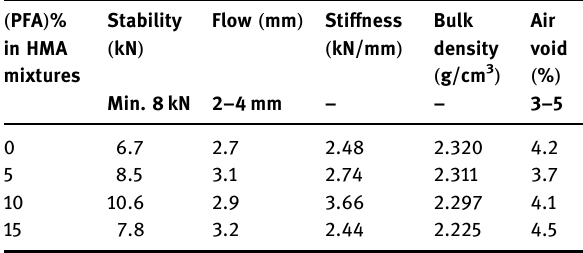
Table 5: Marshall volumetric properties ( ASTM D6927 - 06 )